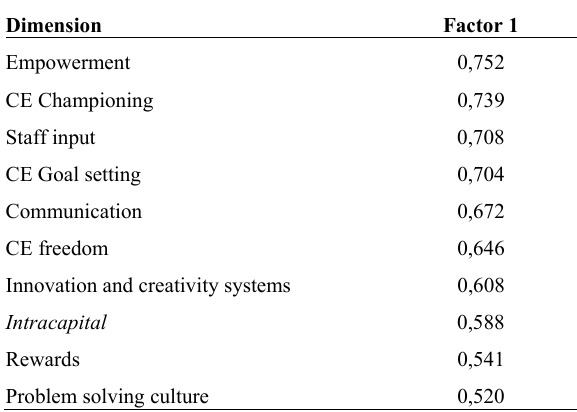
Table 3: Rotated